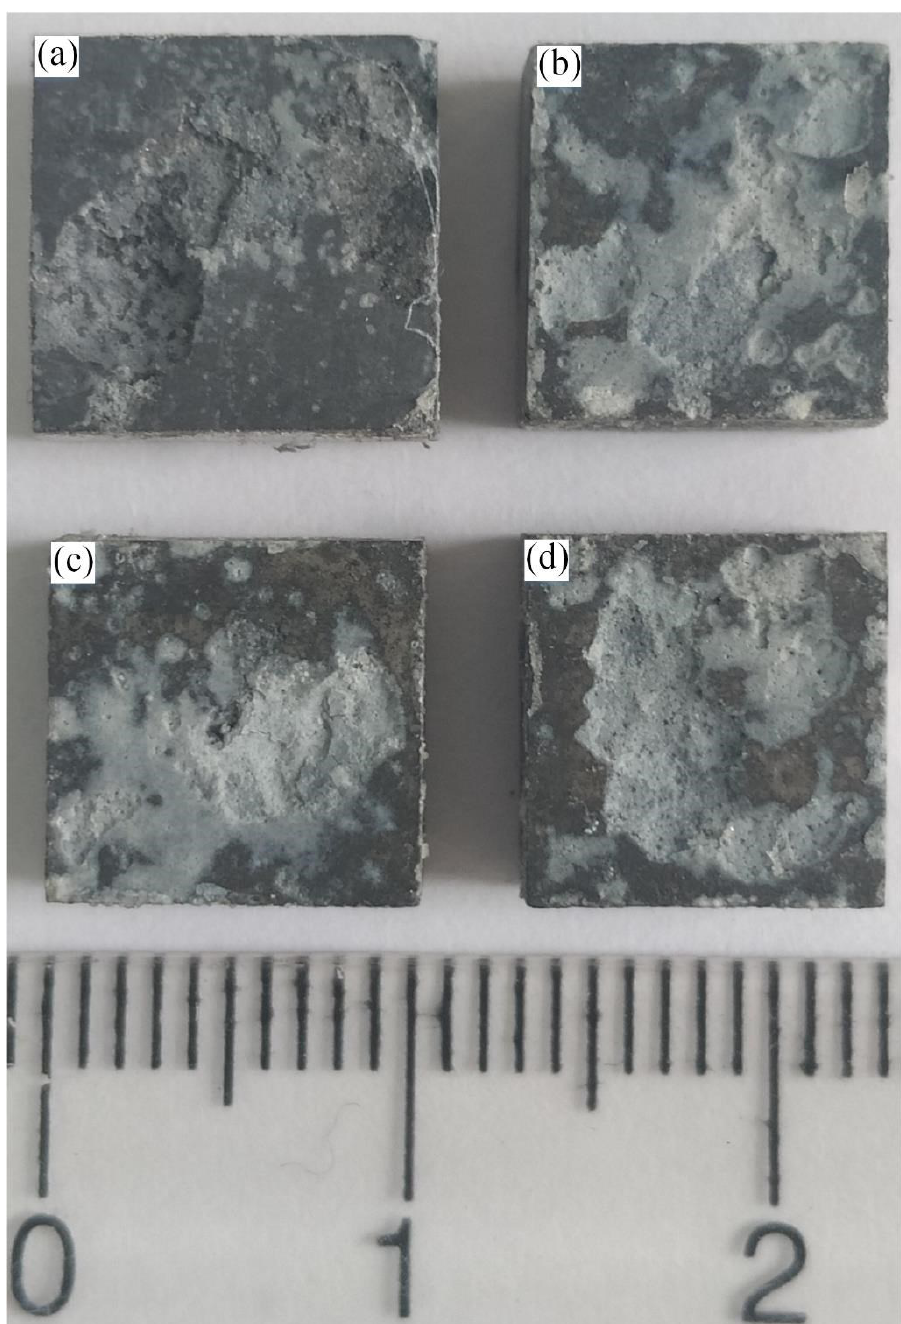
Figure 9. Macroscopic corrosion topography after immersion in SBF solution for ten days: ( a ) untreated; ( b ) 1.19 GW / cm 2 ; ( c ) 1.99 GW / cm 2 ; ( d ) 2.79 GW / cm 2